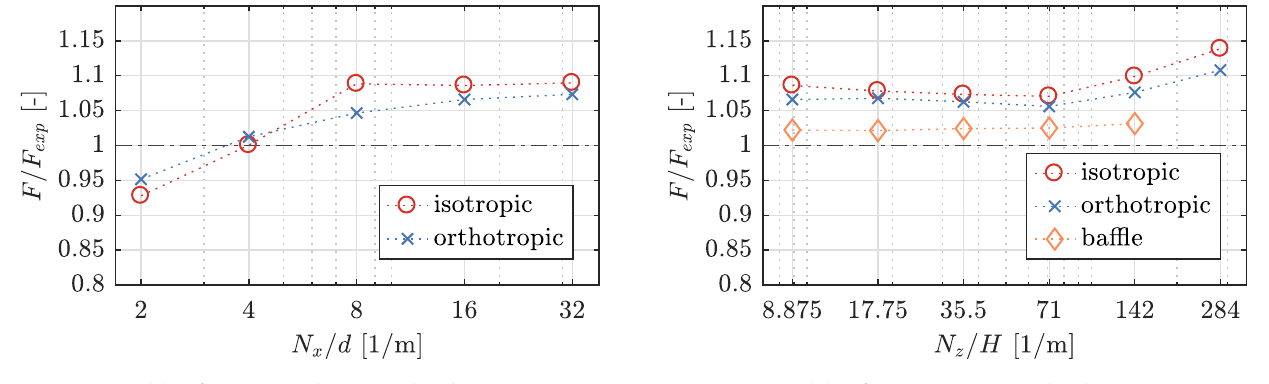
Figure 5. Mesh independence study for the normalized horizontal force on the 2D sheet, F / F exp , separately for the number of ( a ) cells per sheet thickness (where d = 10 mm) in horizontal x -direction ( N x / d ) and ( b ) cells per wave height (where H = 177.5 mm) in vertical z -direction ( N z / H ), including the force results from models with all